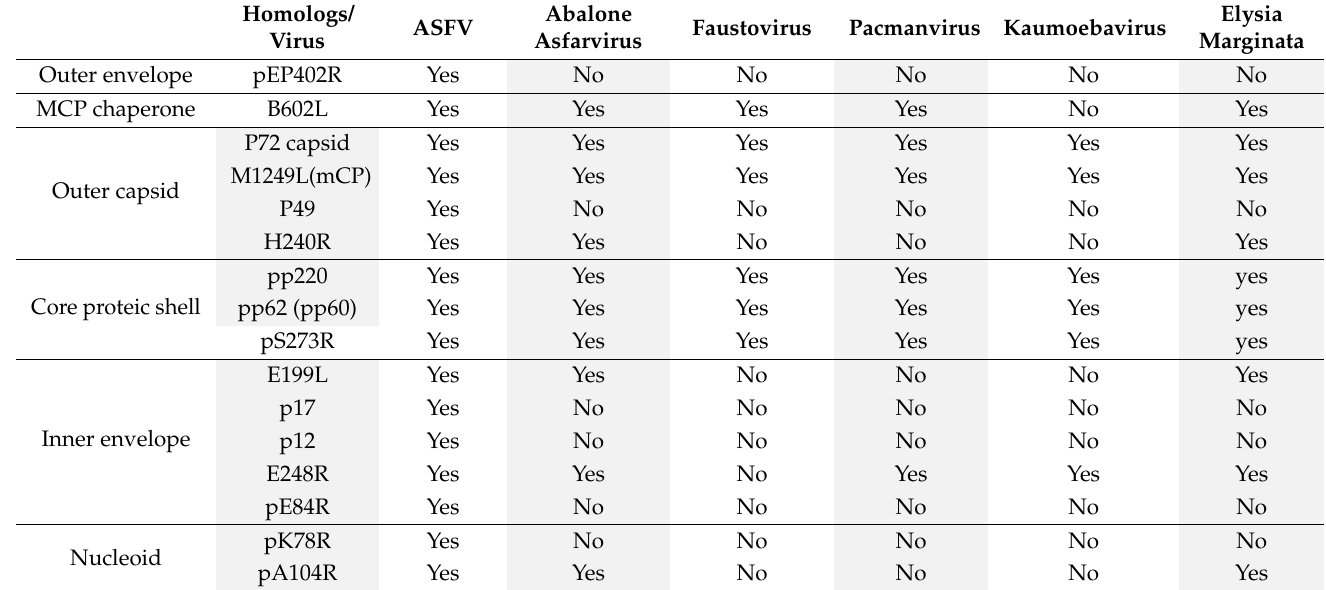
Table 1. Main identified virion proteins in ASFV and their homologs in other related